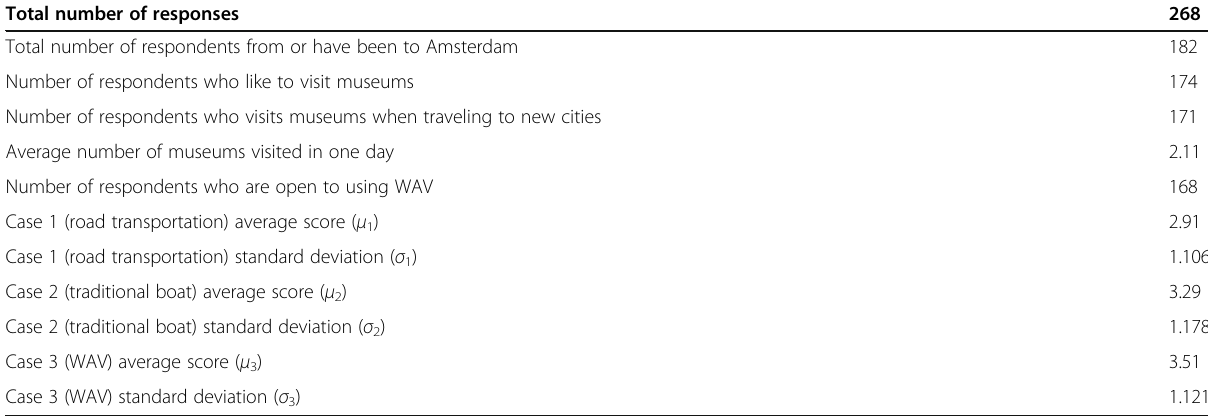
Table 4 Results of the museum visits survey Total number of